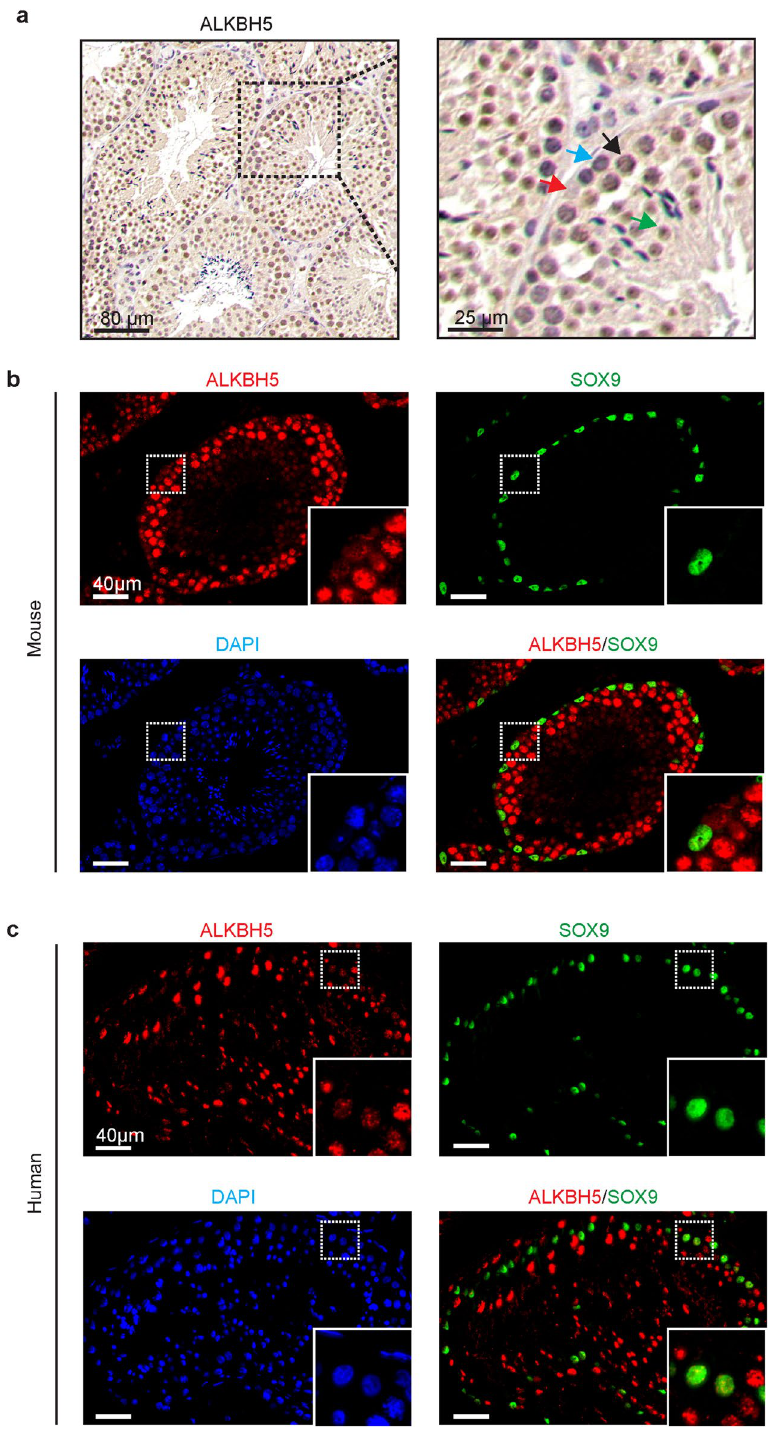
Fig. 1 ALKBH5 expression in human and mouse testes. a Immunohistochemical analysis showing ALKBH5 expression in the testis of wild‑type mice ( n arrow, spermatocytes; green arrow, spermatids; b , c Immunofluorescence analysis showing ALKBH5 expression (SOX9, a marker of testicular Sertoli cells) in mouse ( n normal